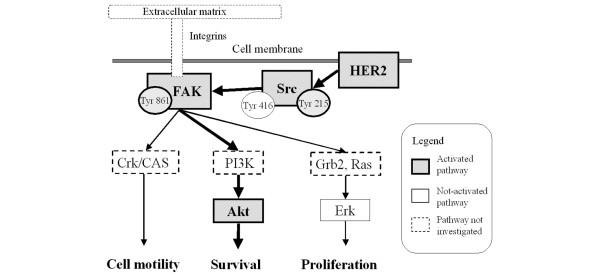
Scheme depicting signalling transduction in breast cancer involving HER2, Src, focal adhesion kinase (FAK), phosphatidylinositol 3-kinase (PI3K), Akt and Erk.